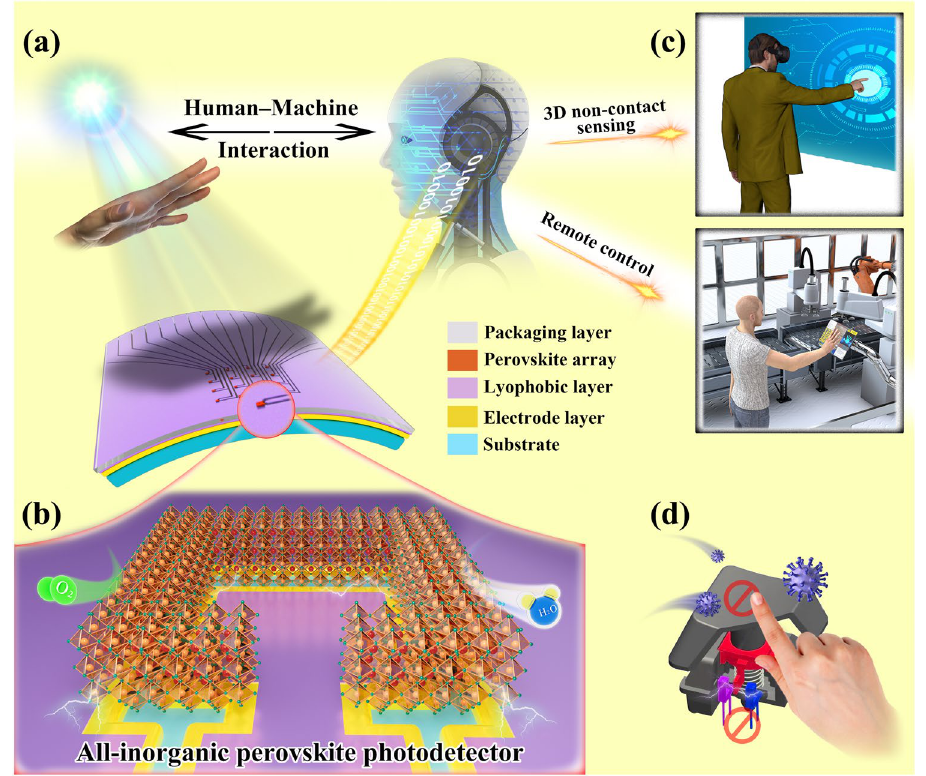
Fig. 1 Schematic of CsPbBr 3 photodetector array-based human–machine interaction process for MIT. a A schematic diagram of the structure of the human–machine interface. The device is composed of a packaging layer, a lyophilic layer, a perovskite film array, an electrode layer, and a substrate. b Schematic diagram of the split-ring structured perovskite photodetector. c Applications of device in human–machine interaction. d This durable and sterile interface versus the mechanical button with